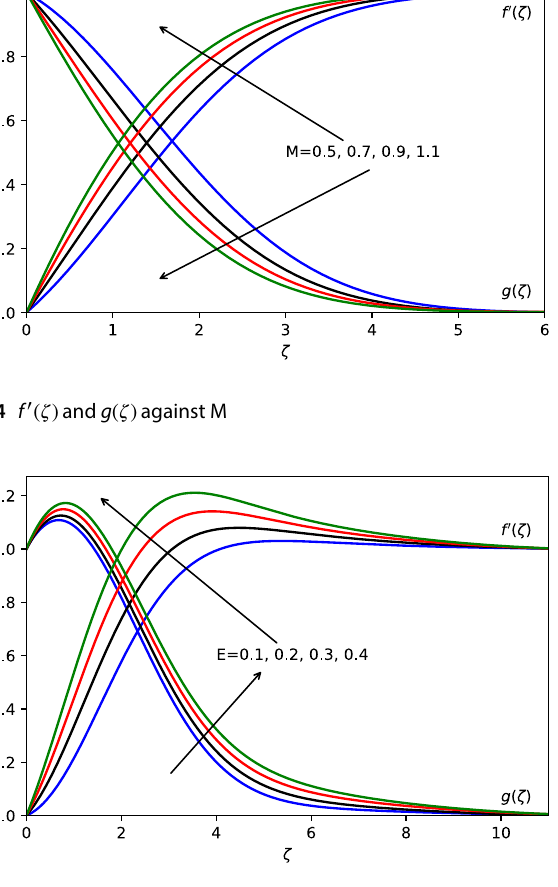
Fig. 5 e f � ( 𝜁 ) and g ( 𝜁 ) against E